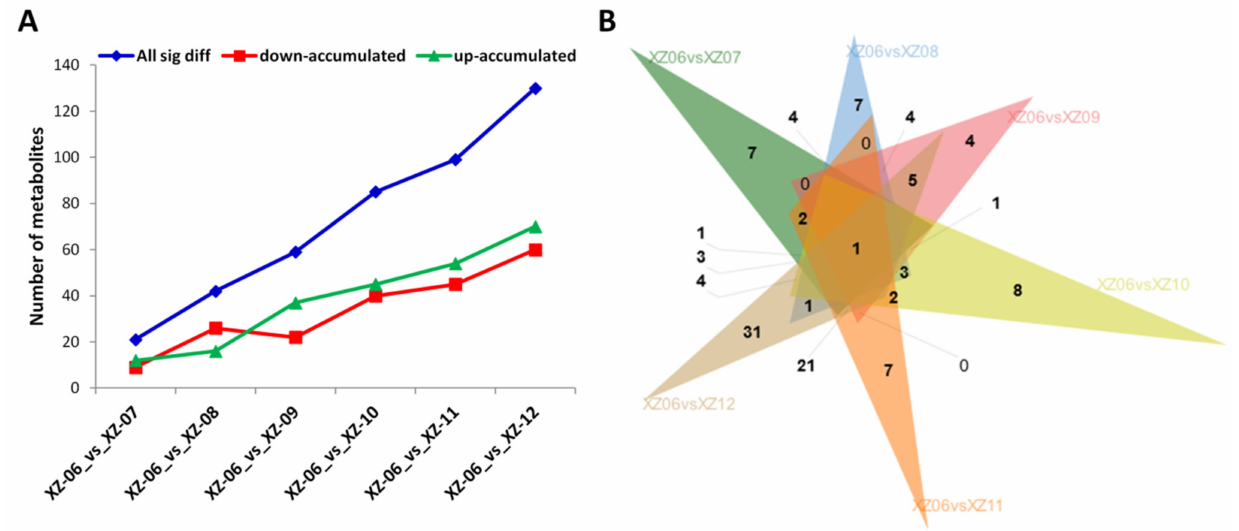
Figure 5. ( A ) Number of upregulated and downregulated differentially accumulated metabolites (DAM) between the different stress gradients. The blue line shows the difference in total DAMs content between the stress gradients. The green line represents the upregulated while the red line represents downregulated DAMs, respectively. ( B ) Venn diagram showing the number of shared and common DAMs between the different compared salt-alkaline stress